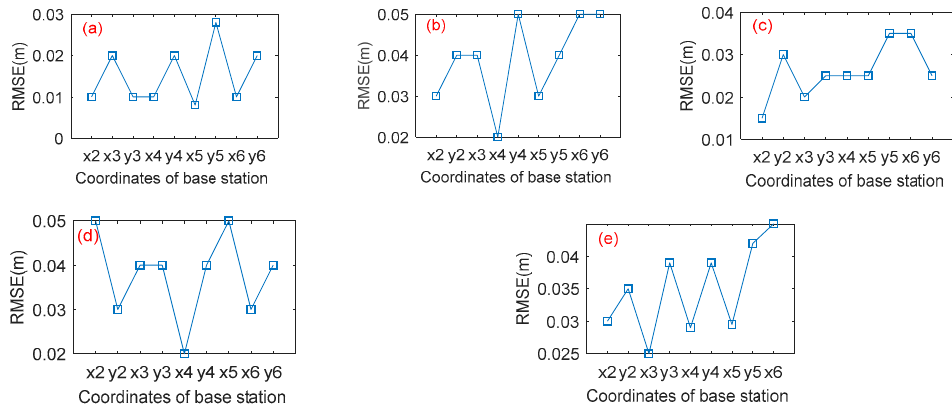
Figure 7. The RMSE of the hexagonal distribution (( a ) the x -axis is determined by the BS 1 and 2; ( b ) the x -axis is determined by the BS 1 and 3; ( c ) the x -axis is determined by the BS 1 and 4; ( d ) the x -axis is determined by the BS 1 and 5; ( e ) the x -axis is determined by the BS 1 and 6).